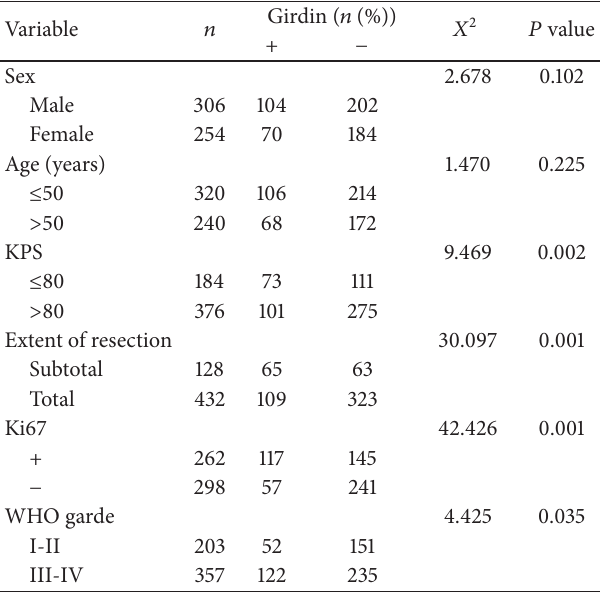
Table 1: Relationship between Girdin expression and clinic- pathological factors of 560 Gliomas.